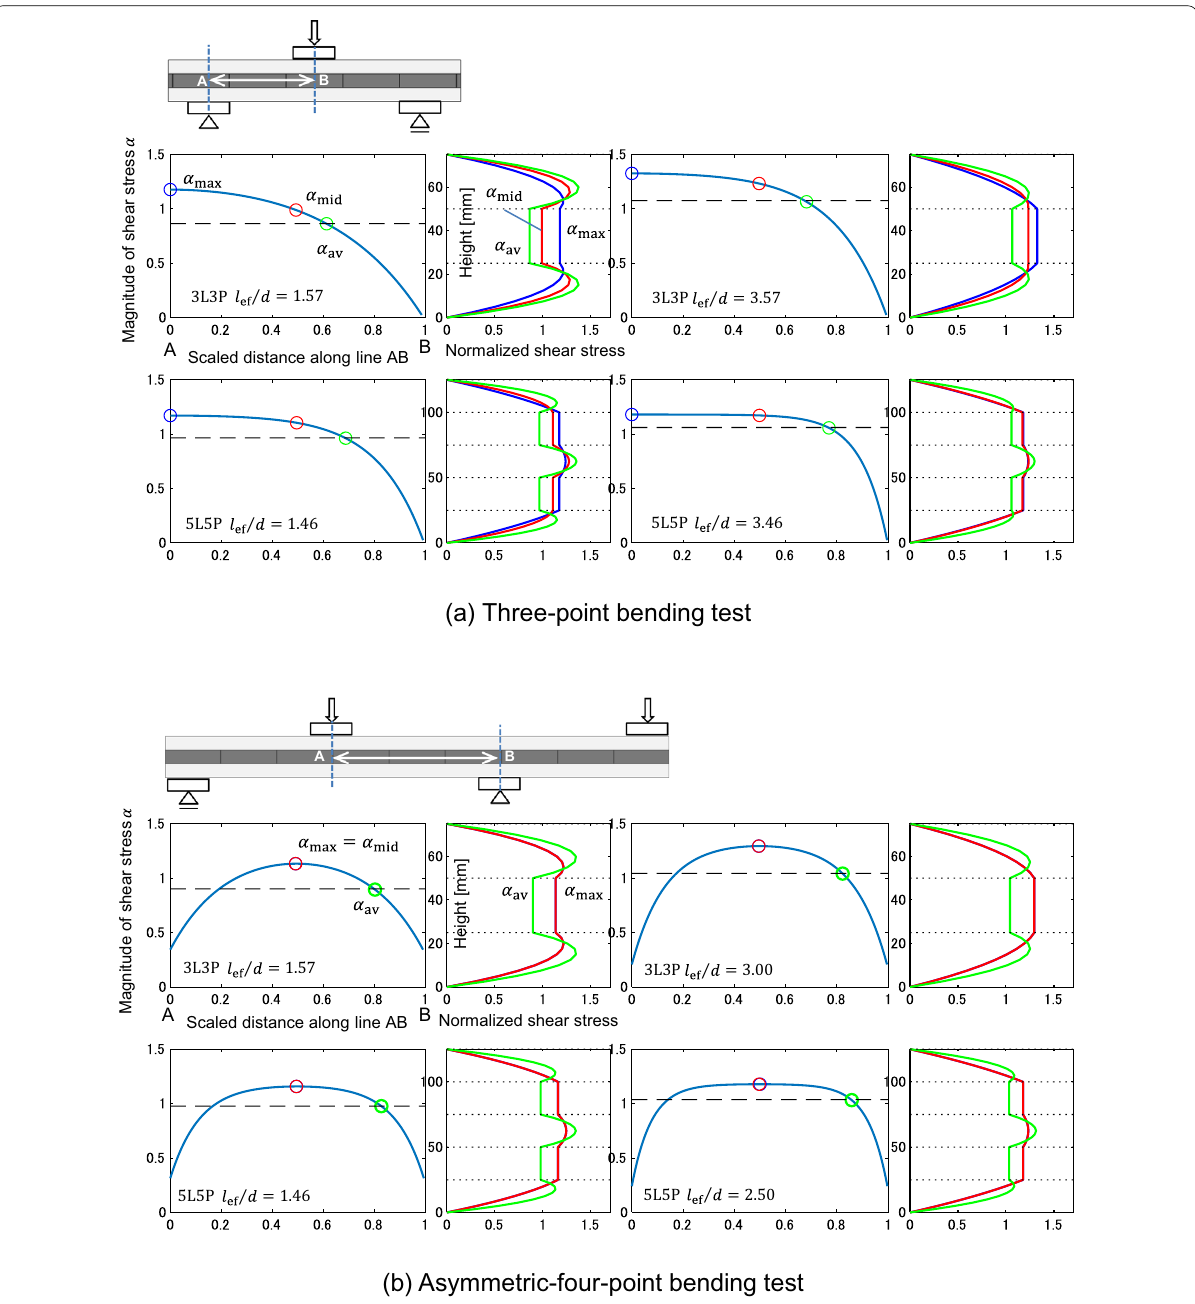
Fig. 11 Horizontal distribution of shear stress in the cross layer and cross-sectional shear stress distributions at representative